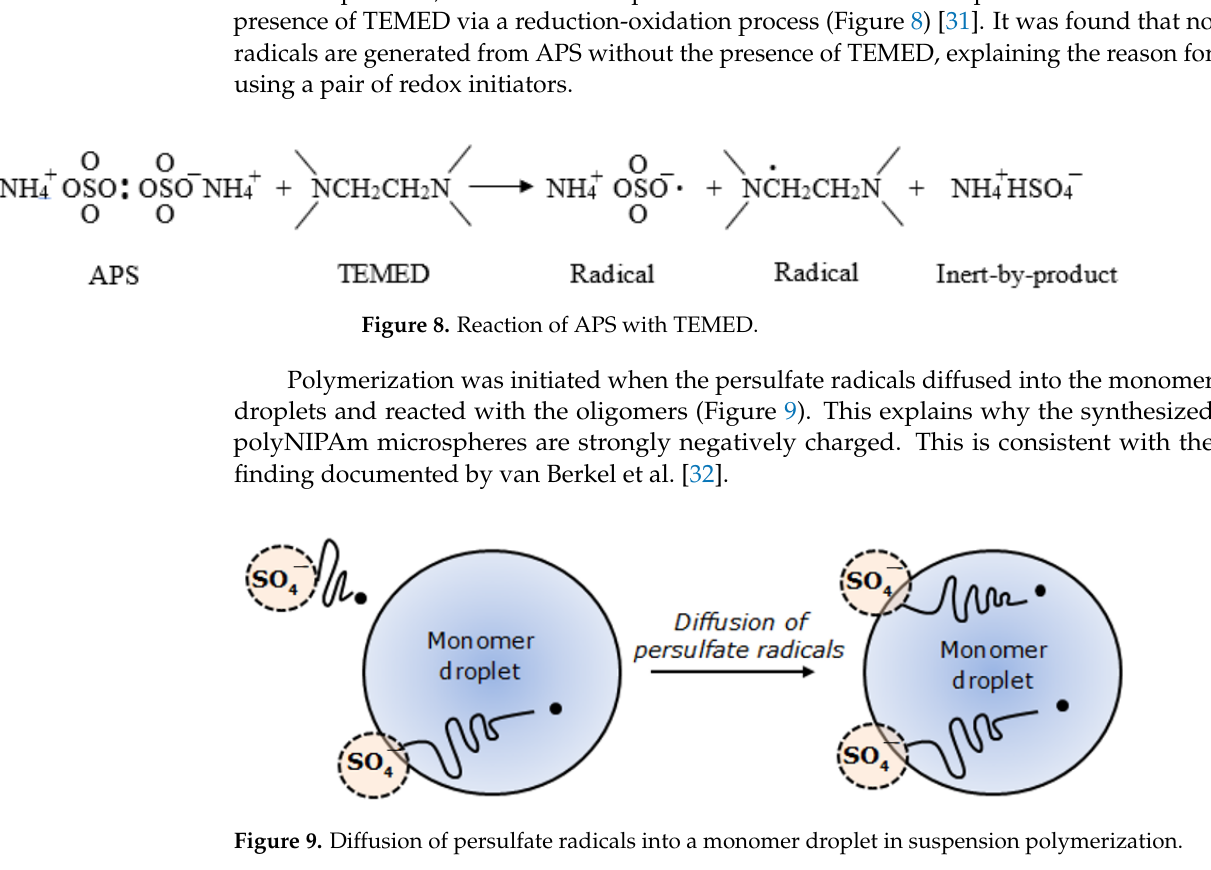
Figure 9. Diffusion of persulfate radicals into a monomer droplet in suspension polymerization.